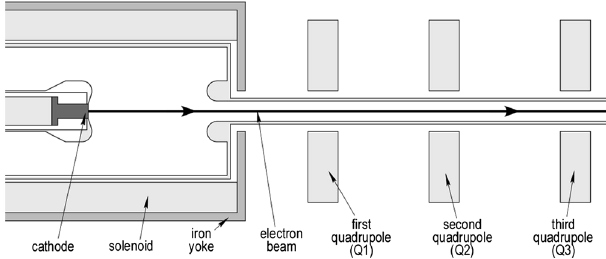
FIG. 13. Emittance evolution in the LCLS injector operated as an FBTwhere eigp is the higher ( “ plus ” ) eigen-emittance, eigm is the lower ( “ minus ” ) eigen-emittance, and the x and y projected emittances lie on top of each other (from